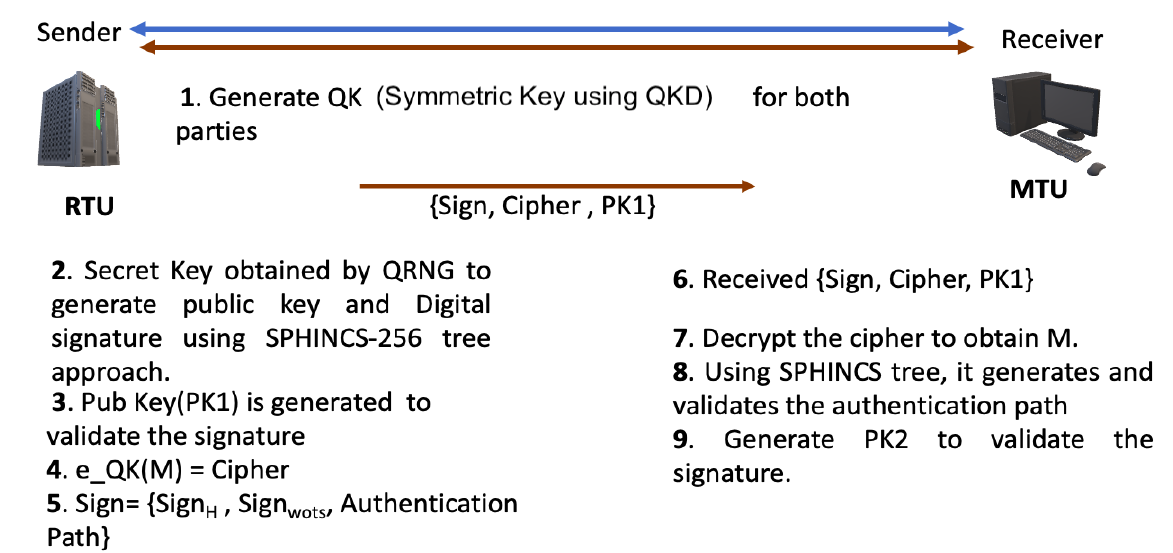
Figure 1. The Proposed Scheme